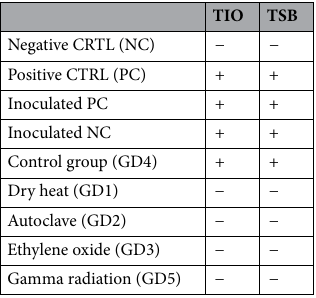
Table 3. Sterility test—the signals “ + ” indicates the presence of microorganisms, and “−“ absence, PC and NC are abbreviations of “Positive Control” and “Negative